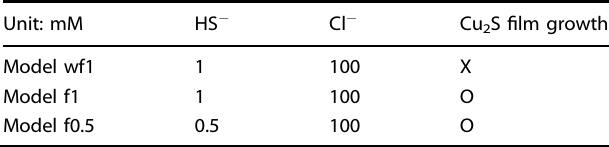
Fig. 5 Validation of simulated corrosion potential with experi- mental data. Comparison of data experimentally measured by Chen et al. (2010 and 2017) and numerically simulated in this study for corrosion potential ( E corr ) of Cu immersed in 0.1 M Cl − with 1 mM HS − and 0.5 mM HS − solutions 29,30 . Table 1. Summary of three corrosion models for HS − and Cl −